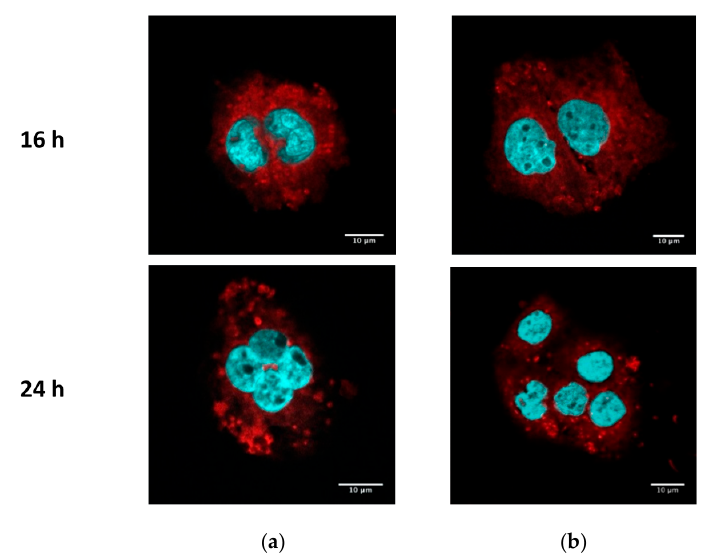
Figure 5. Internalization of fSLN and fPEG – SLN in SCC-25. SCC-25 cells were seeded in cover glasses at 2 × 10 4 cells/well. The next day, cells were washed and incubated with 0.2 mg/mL of fPEG – SLN ( a ) or fSLN ( b ) suspensions. Fluorescence intensity of R18 (red) was analyzed by confocal microscopy and nuclei were stained with DAPI (blue). Scale bar: 10